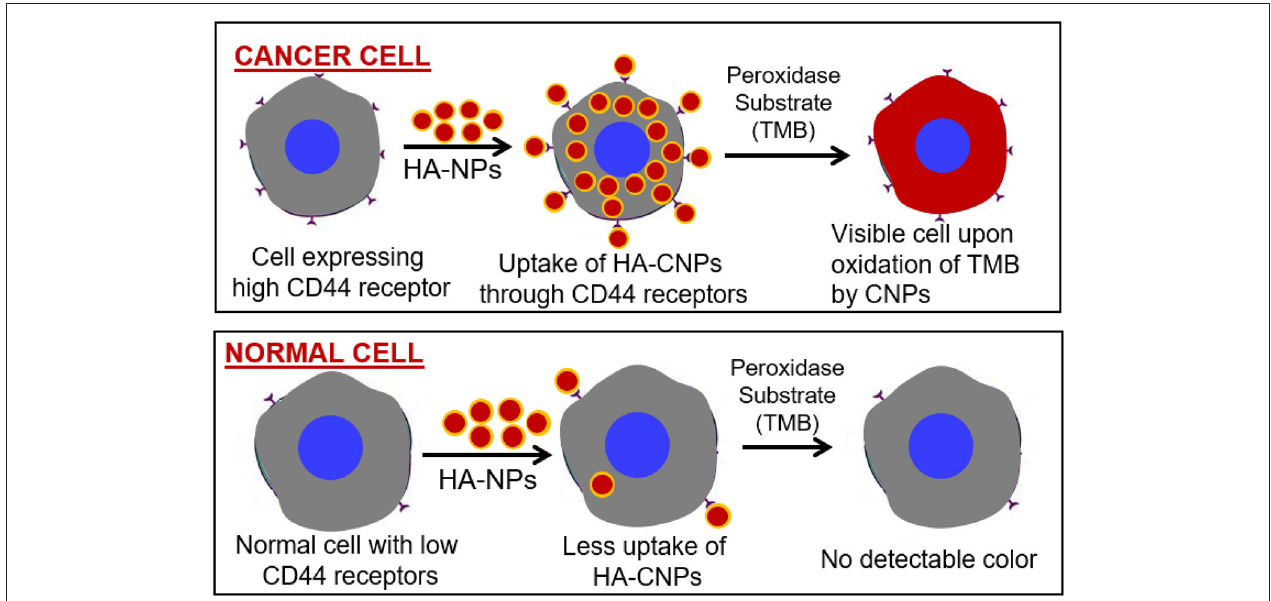
FIGURE 2 | Peroxidase enzyme mimetic nanozymes can differentiate between cancer and normal cells. Peroxidase mimetic cerium oxide nanoparticles (CNPs) coated with HA can bind with the CD44 receptors expresses selectively on cancer cells. During peroxidase reaction these nanoparticles could convert the peroxidase substrate into colored product leading to the identification of cancer cells. Due to the low expression of CD44 receptors on normal cells, peroxidase mimetic nanoparticles would not be attached with cells and thus exhibit no peroxidase reaction.